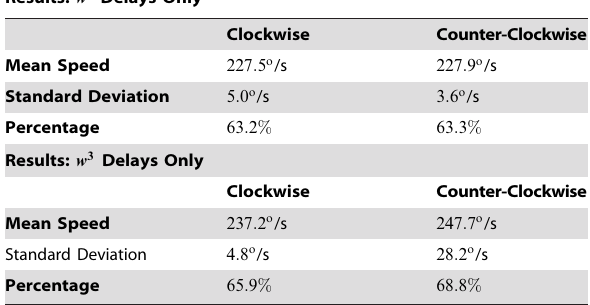
Table 4. The speed of movement of the head direction cell activity packet during testing with axonal conduction delays in either the w 2 or w 3 synapses but not both.